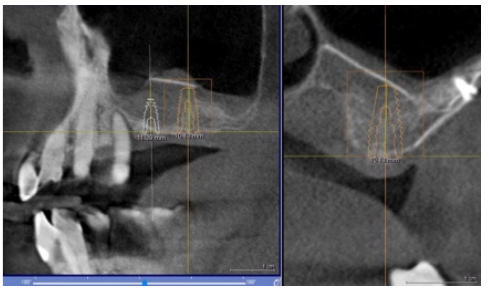
Figure 1. ( a , b ): First quadrant clinical aspect and TAC X-ray image. A full-thickness flap was incised, and a bone window was made. A 25 × 35 mm foil was “L” shaped and applied in the window bone to allow its short side to be fixed on the vestibular bone and the long side overturned inside the sinus to maintain the created volume (Figure 2a,b). Figure 2. ( a ) shaped foil; ( b ) foil fixed to the bone window; ( c ) bone surgical site isolation. The space between the sinus floor and the sinus membrane was filled with blood clot and a second foil was shaped and fixed to vestibular bone in order to separate the cavity from the surrounding soft tissues (Figure 2c). Six months later, a full-thickness vestibular flap was made (Figure 3a) to remove the foil barriers and to proceed with the implant insertion (Figure 3b). Figure 3. ( a ) newly formed bone tissue; ( b ) implant placement. The pre-implant CT showed (Figure 4) the new bone volume obtained with the procedure, which was sufficient to allow the implant insertion.